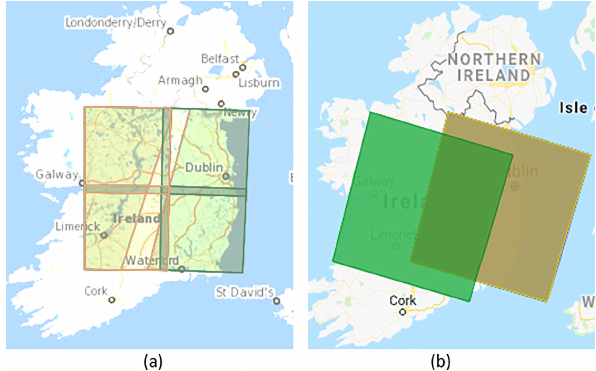
Figure 2. Footprints over Clara, Co. Offaly, Ireland (a) Sentinel- 2, L2A, Tile_Id – 29UNV (https://scihub.copernicus.eu, last ac- cess: 5 March 2018) (b) Landsat-8, OLI + TIRS, Path 207, Row 023 (https://earthexplorer.usgs.gov/, last access: 19 February 2018)